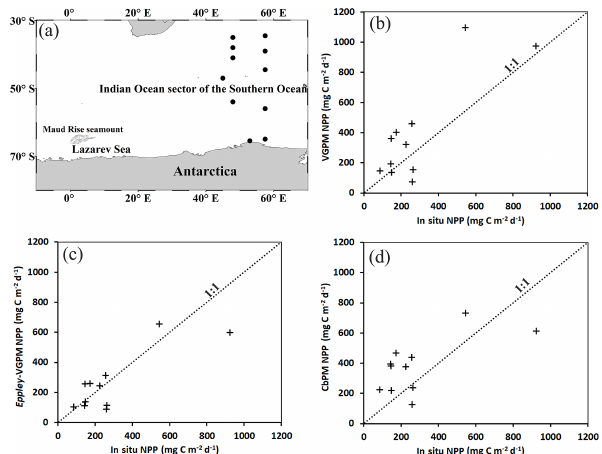
Figure 3. (a) Circles showing the locations of in situ net primary production (NPP) from the 13 C tracer during the Indian scientific expedition to the Southern Ocean (February to April 2009). Scatter plots between in situ NPP and (b) VGPM, (c) Eppley -VGPM, and (d) CbPM NPP estimations. NPP: net primary production; CbPM: carbon-based productivity model; VGPM: vertically generalized production